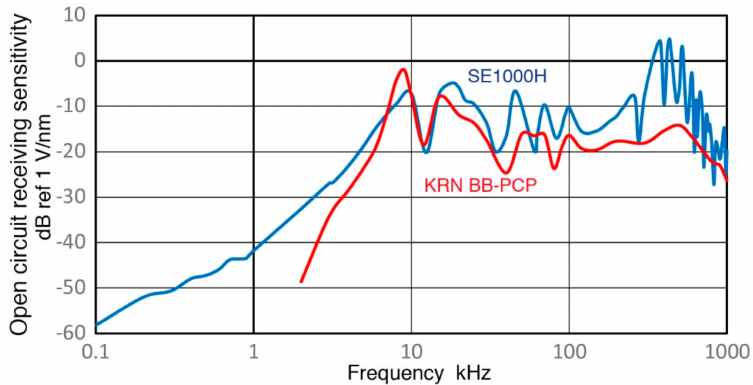
Figure 23. A comparison of two open-circuit receiving sensitivity spectra for SE1000H (blue) and KRN BB-PCP (red). Log-frequency scale.